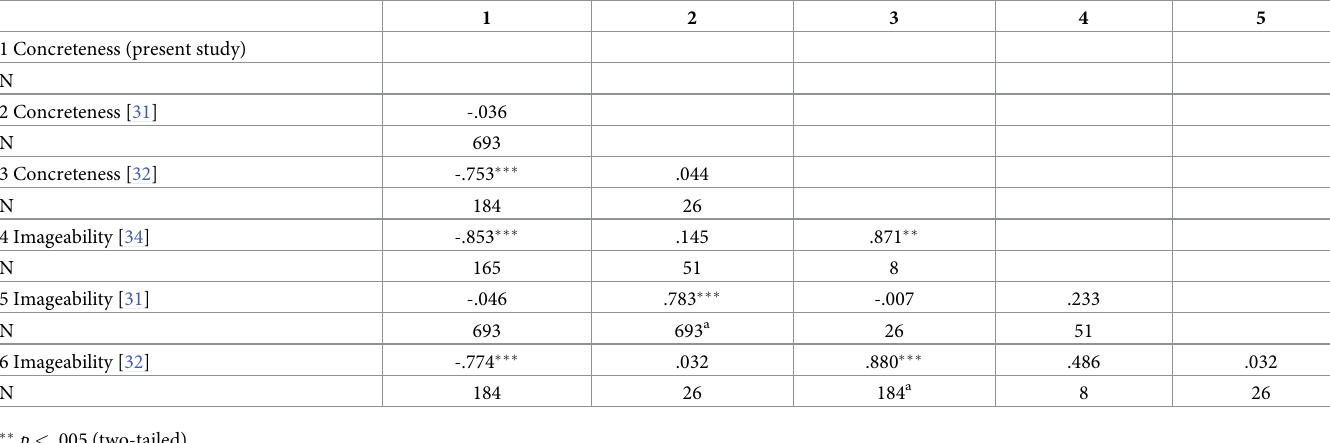
[25], in Portuguese). To further verify the validity of the current ratings, we therefore exam- ined correlations of our concreteness ratings with imageability ratings retrieved from past studies. Both Yao et al. [31] and Yee [32] had collected imageability ratings. Xu, Kang, and Guo [40] also collected imageability ratings for a set of two-character Chinese words stimuli. Correlation coefficients between concreteness and imageability ratings are presented in Table 2. Most importantly, the present concreteness ratings were well-correlated with both imageability ratings by Xu et al. [34] and imageability ratings by Yee [32], supporting the valid- ity of the current concreteness ratings (Fig 6A and 6B). We investigated possible reasons for the lack of correlation between the current ratings and Yao et al. [31]. First, for the concreteness rating task, Yao et al. seemed to instruct participants to think of not only mental images associated with the to-be-rated word but also scenarios in which the word could occur. (The literal translation of the concreteness rating instruction is “concreteness is the degree to which one can think of an image or a scenario in reality.”) Table 2. Correlations of concreteness and imageability ratings between